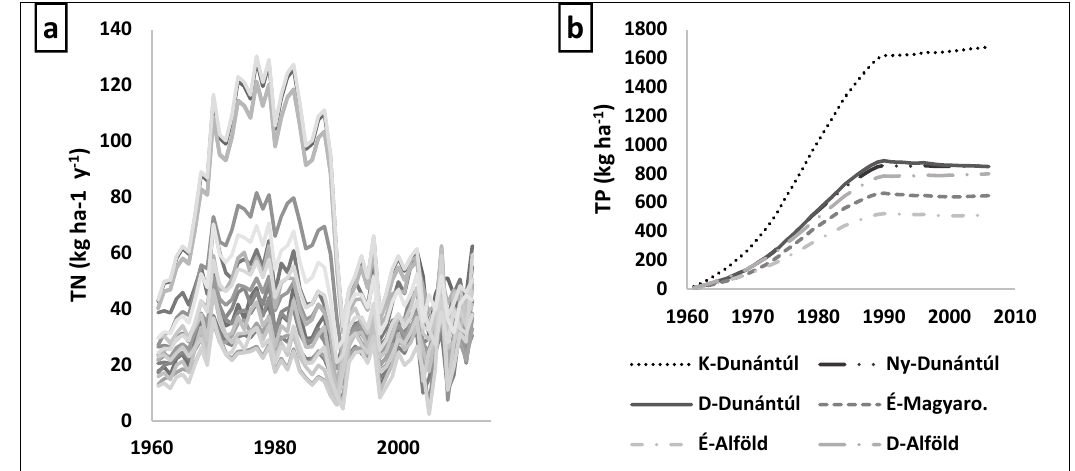
Figure 2. Total nitrogen (TN) surplus by the Hungarian counties (each county is represented by one line) (kg ha − 1 y − 1 ) ( a ) and accumulated total phosphorus (TP) by the Hungarian regions (kg ha − 1 É,D,K,NY stand for north, south, east and west) ( b ).